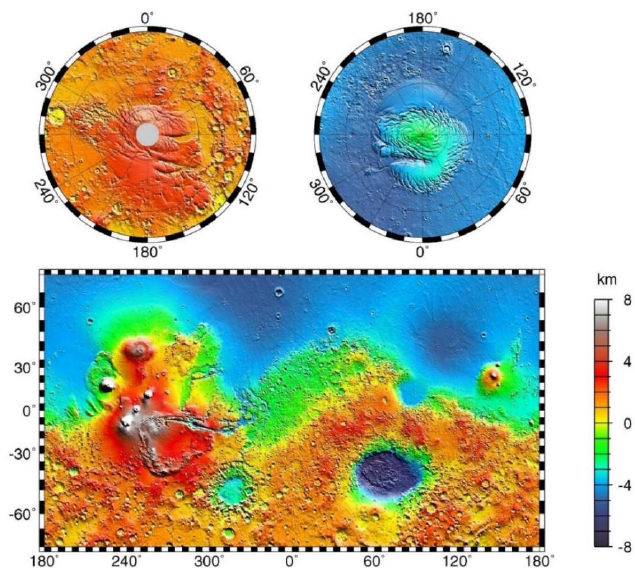
Figure 8. The blue region of low topography in the Martian northern hemisphere is hypothesized